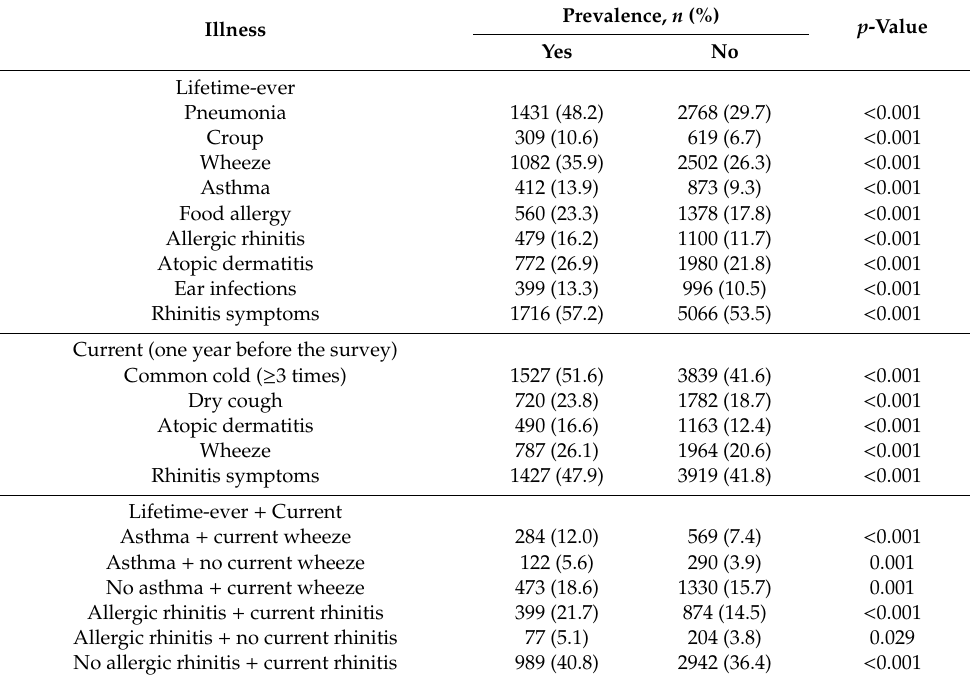
Table 2. Comparisons of prevalences for childhood asthma, allergies, and airway illnesses among children with di ff erent situation of antibiotics exposure in the first year of lifetime (Yes vs. No).